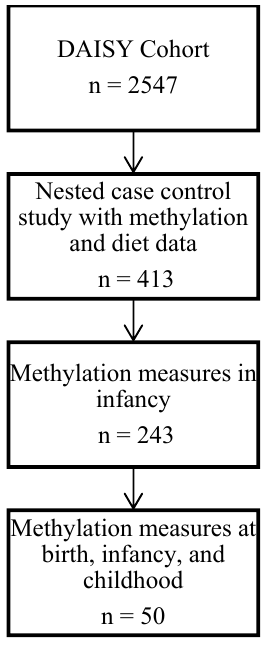
Figure 1. Flow chart of study population selection.